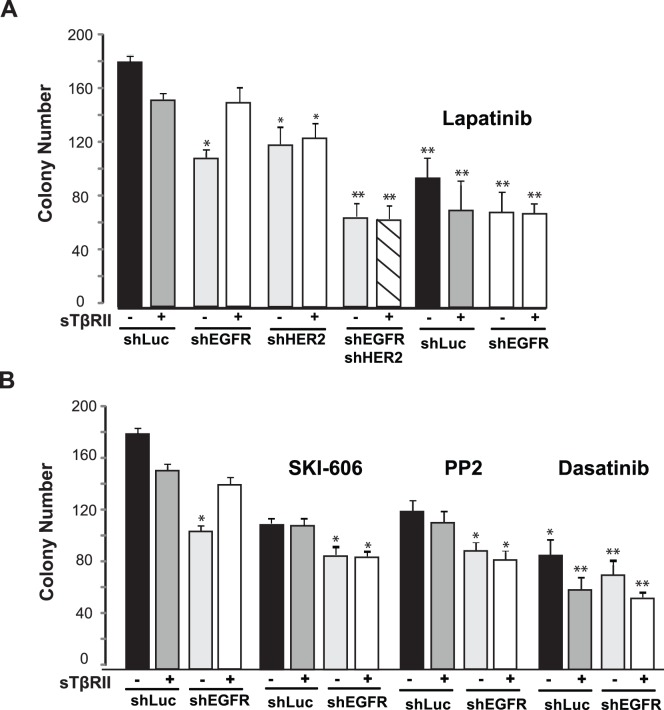
Effects of HER2 silencing, lapatinib, and src inhibition on sTβRII-mediated reversal of growth suppression.A. HER2 silencing and inhibition. T3M4 cells were infected with shLuc-LV (shLuc), shEGFR-LV (shEGFR), shHER2-LV (shHER2), or both shEGFR and shHER2, in the absence or presence of WPT-sTβRII (sTβRII) or 1 µM lapatinip. Colony formation was monitored in 3-D culture. Data are the means ± SEM of triplicate determinations from three independent experiments. *p<0.05, and **p<0.01, when compared with control. B. Effects of c-Src inhibition. T3M4 cells were incubated in the absence or presence of the src kinase inhibitors SKI-606 (1 µM), PP2 (1 µM) and dasatinib (100 nM), and effects on colony formation in 3-D culture were determined. Data are the means ± SE of triplicate determinations from three independent experiments. *p<0.05, **p<0.01, when compared with respective controls.